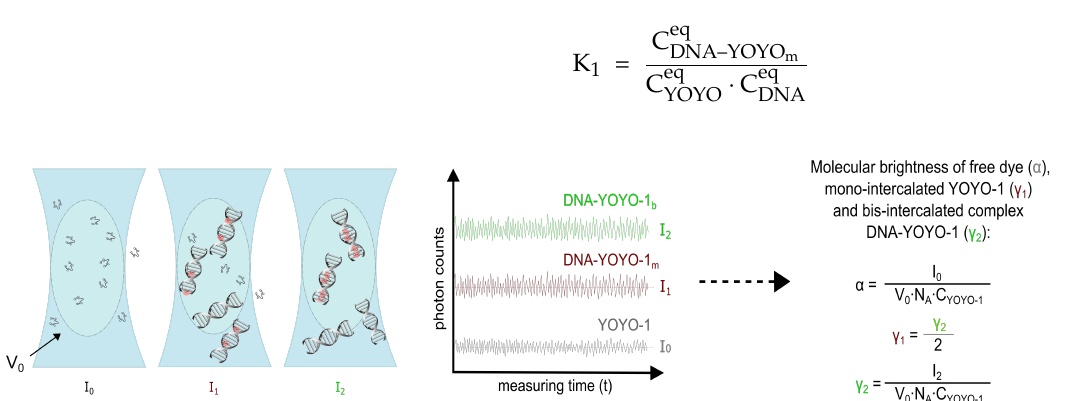
Figure 5. Scheme of the method of molecular brightness determination. In the confocal volume (V 0 ) we collect photons in time (t) by the detector. Knowing the intensity of free and bound dye (I 0 , I 1 and I 2 ) we determine MB for free dye ( α = 28 counts per molecule per second, cpm), mono-intercalated YOYO-1 ( γ 1 = 8400 cpm) and bis-intercalated complex ( γ 2 = 16,800 cpm),